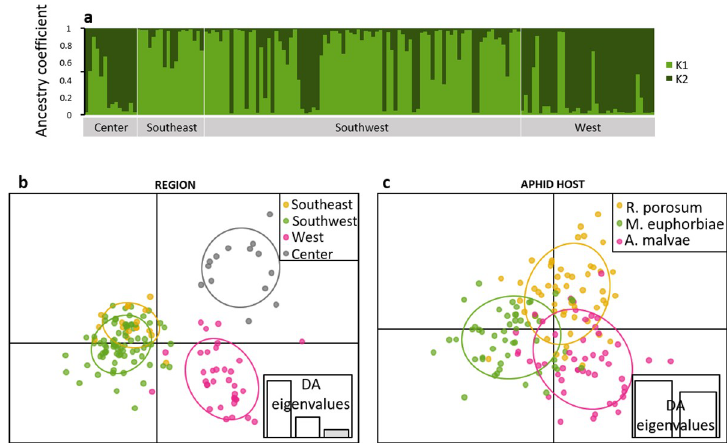
Fig 5. Genetic structure of wild Aphidius ervi collected in strawberry greenhouses based on seven microsatellite loci: (a) inference of population structure using Bayesian clustering with the program STRUCTURE (K = 2, the most probable number of clusters is presented, coefficient of ancestry is an average on ten runs) and Discriminant Analysis of Principal Components according to (b) the region of sampling and (c) to the aphid host. Putative populations are distinguished by colors and inertia